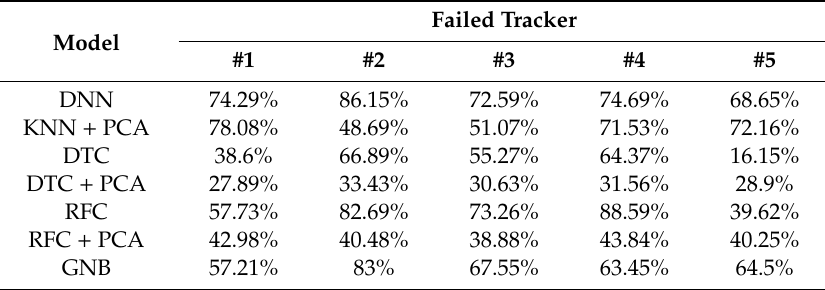
Table 6. Inference accuracy with one tracker